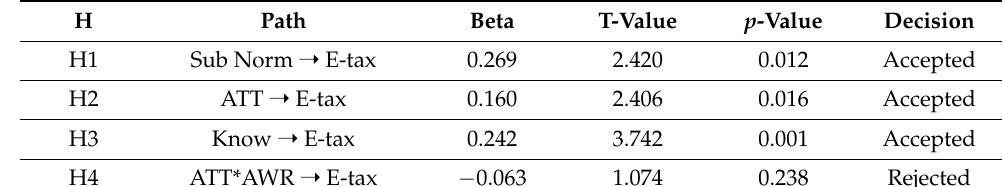
Table 7. Direct and indirect path coefficient and hypotheses testing.